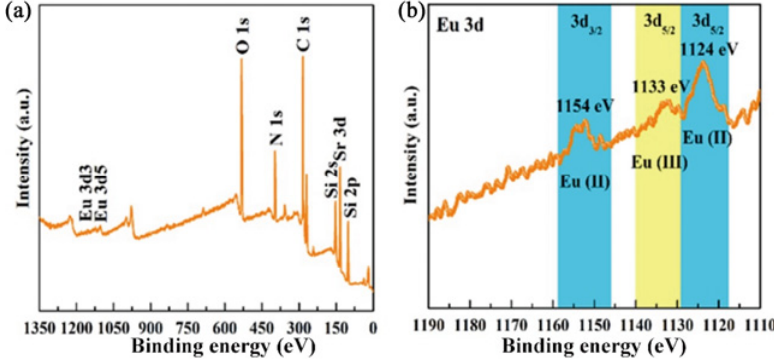
Fig. 8 XPS spectra of Sr 2.97 Si 8 O 4 N 10 :0.03Eu 2+ . (a) Full spectrum and (b) fine spectrum of